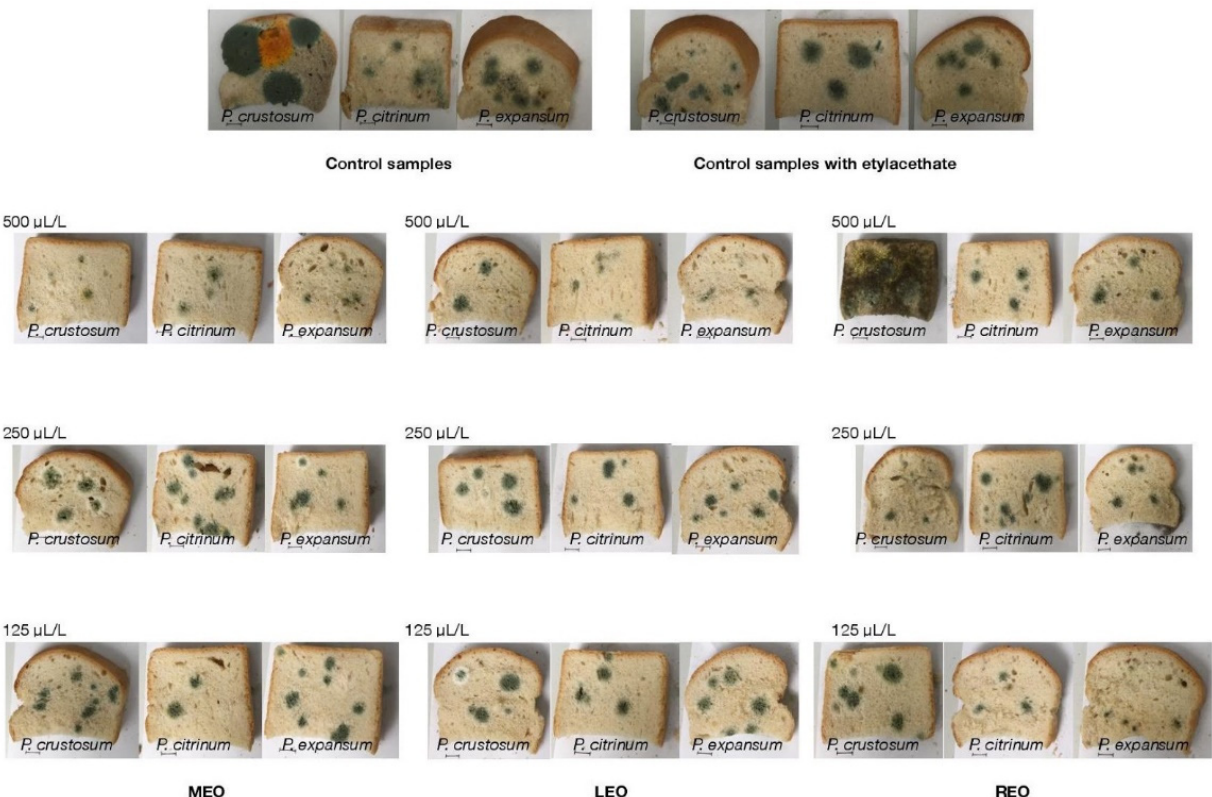
Figure 1. In situ analysis of antifungal activities of the EOs (MEO: Mint essential oil; LEO: Lavender essential oil; REO: Rosemary essential oil).